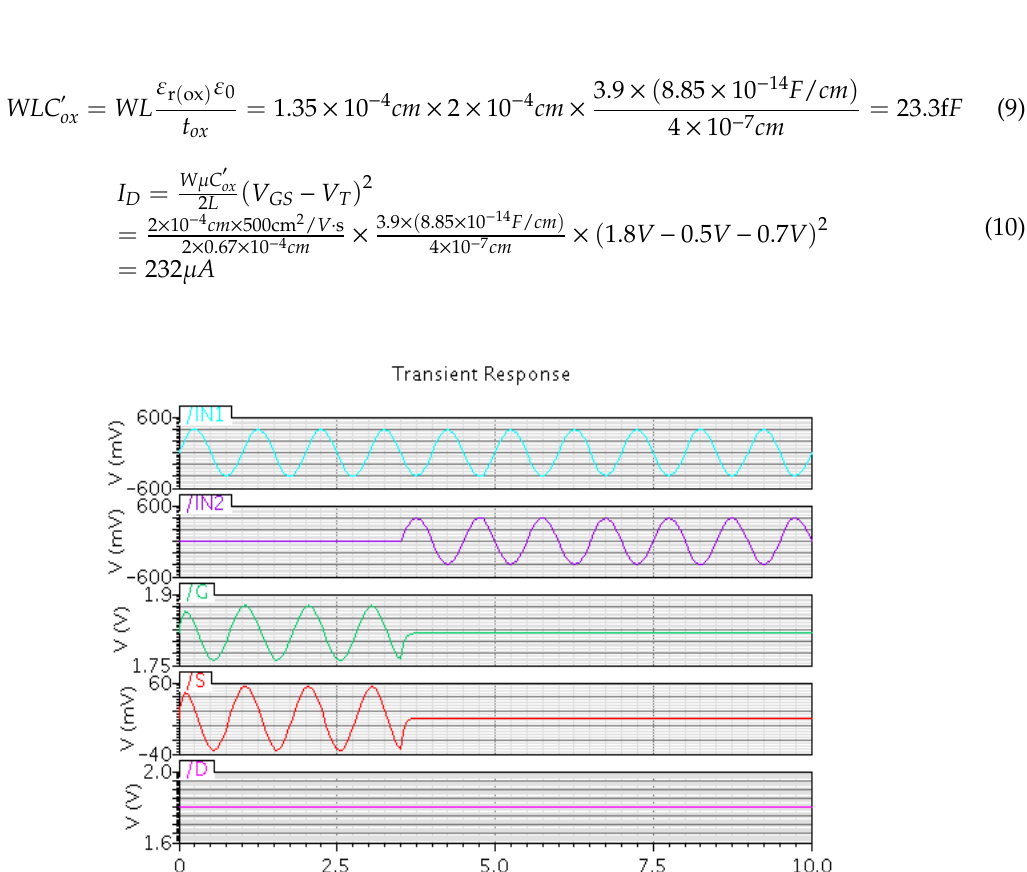
Figure 5. A simulation schematic based on the proposed ANC device with a standard MOSFET M 0 and two capacitors C 0 and C 1 , where capacitors C 0 and C 1 can be seen as the coupling capacitors C FC and C FC ; MOSFET M 0 represents the combination of the floating gate, the source, the drain, 1 2 and the p-bulk; inputs IN 1 and IN 2 are equivalent to the control gates CG 1 and CG 2 ; and two resistors R 1 and R 2 are used to provide the bias potential for the gate.